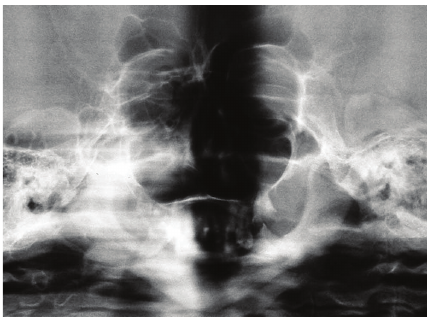
Figure 5: It shows the legs of the patient exhibiting shiny and dry skin.